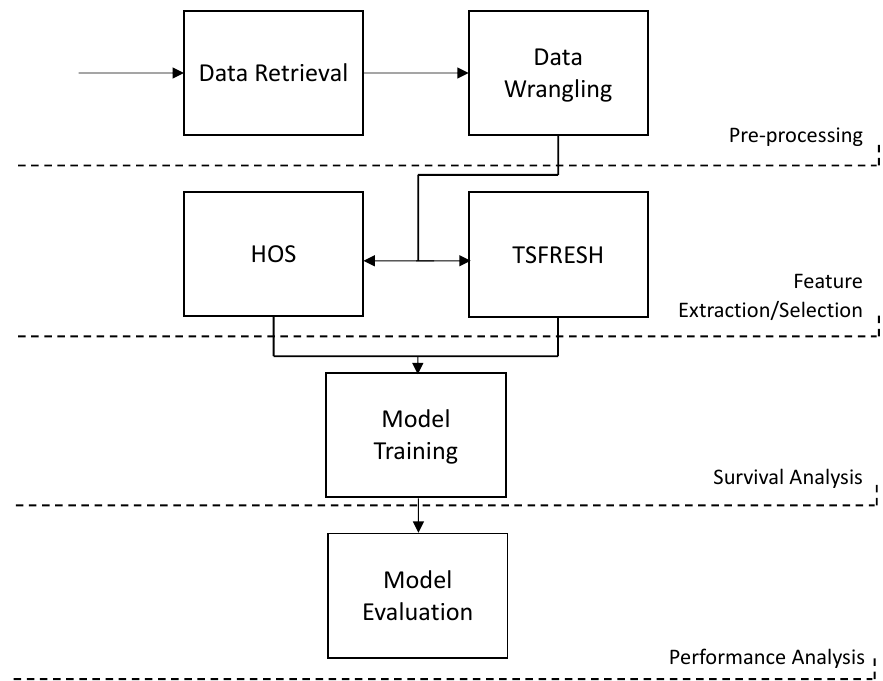
Figure 3. Data transformation flow from data retrieval to performance